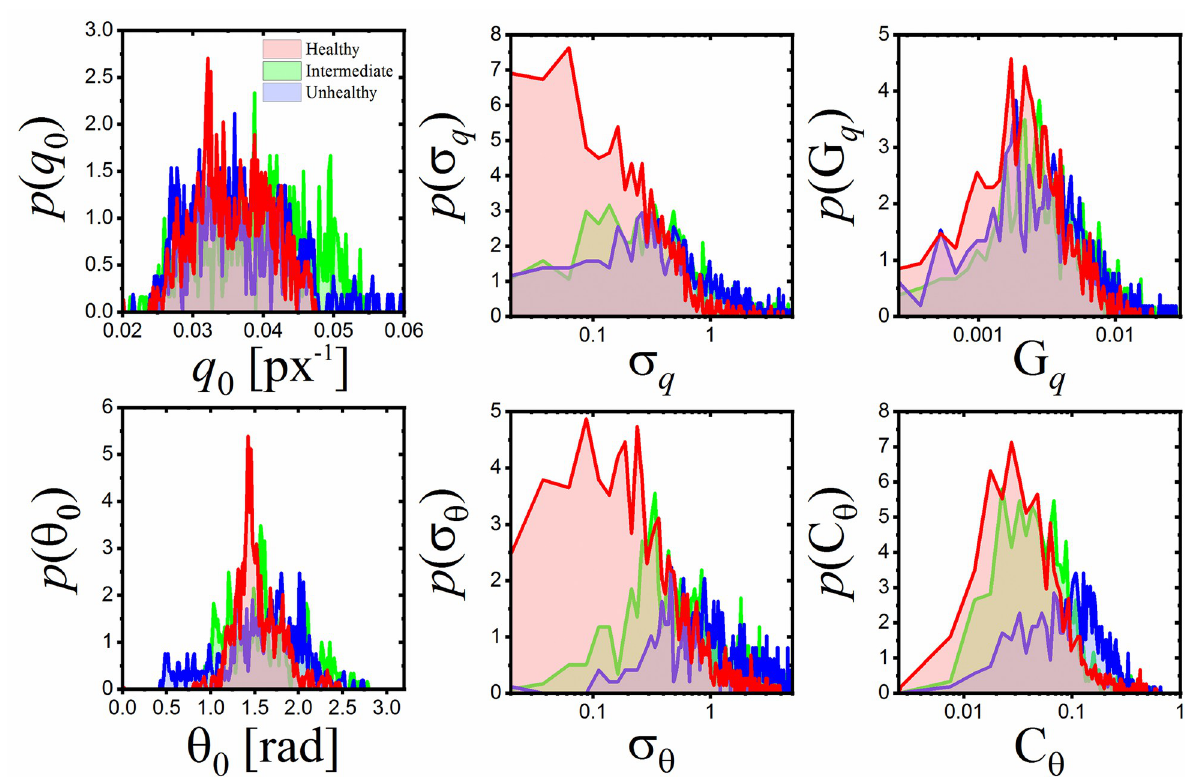
Fig 6. Distributions of pixel values for 6 morphometric maps plotted for Meibomian images classified as healthy, intermediate and unhealthy. Notice that the shape of each distribution depends on the image category (gland ailment). To quantify these changes five measures of distribution were calculated (Entropy, Mean, Variance, Skewness and Kurtosis) giving in total 30 descriptive features for each Meibomian image.